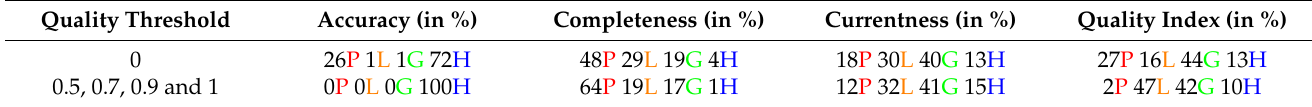
Table 9. Shipments quality evaluation